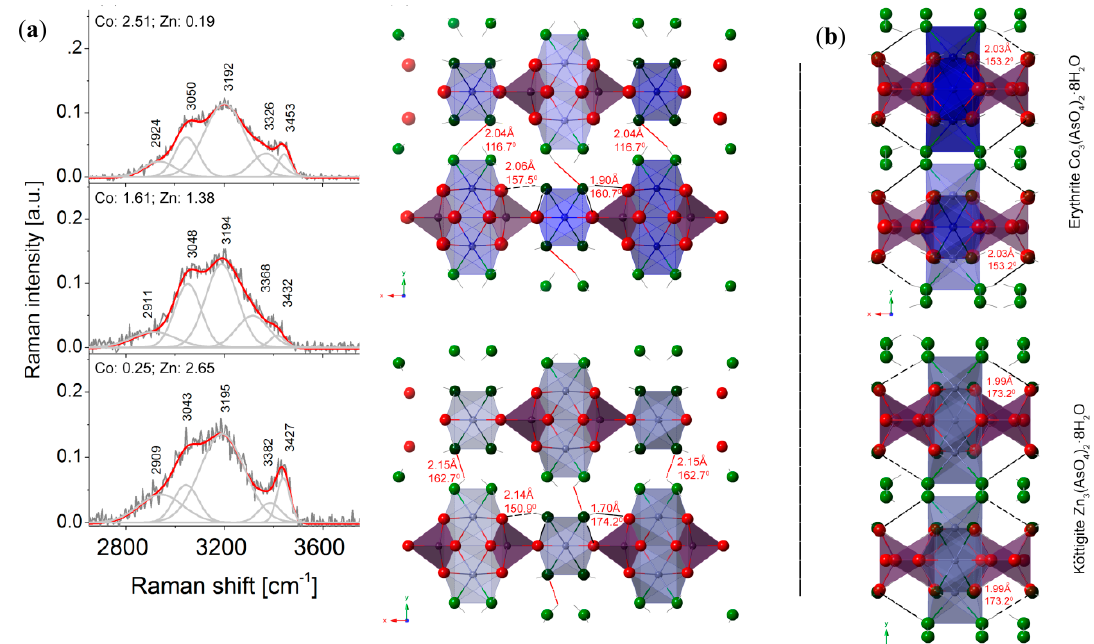
Figure 11. ( a ) Fitted Raman spectra of erythrite–köttigite solid solution in the hydroxyl region; ( b ) part of the structure of erythrite and köttigite with the probable H-bond pattern between hydrogen and oxygen shown in the right side of the figure. Spheres: O (green) related to H-bonds, O (red) in the polyhedra, Co or Zn (blue).